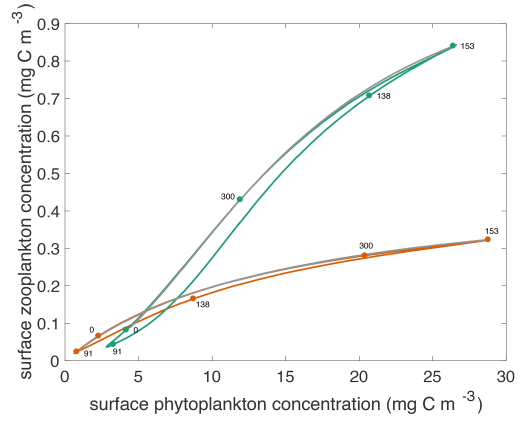
Figure 4. Surface phytoplankton versus zooplankton concentrations through the annual cycle for both models. Green curve shows con- centrations that result from the type III model. Orange curve shows concentrations that result from the type II model. The labeled dots indicate day of year for particular locations in the phase portrait. Over the annual cycle, the phytoplankton and zooplankton popula- tions transit these curves counter-clockwise. The grey curves show the steady state concentrations throughout the annual